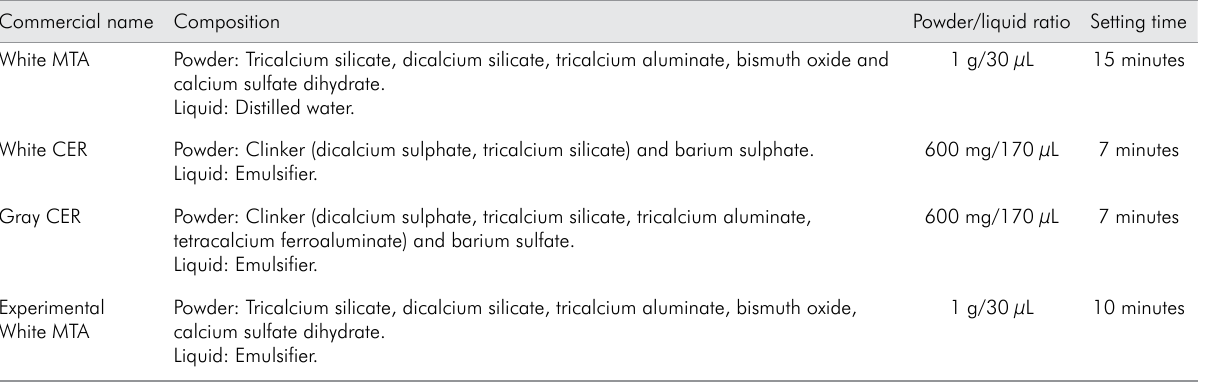
Table 1. Composition, powder/liquid ratio and setting time of cements evaluated in this